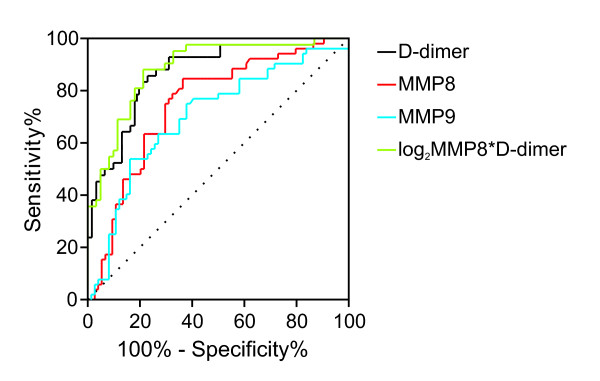
Receiver-operating characteristics (ROC) curve of plasma MMP8, plasma MMP9, D-dimer and combination of MMP8 and D-dimer (log2MMP8*D-dimer) for patients with acute aortic dissection versus subjects receiving an alternative final diagnosis. MMP, matrix metalloproteinase.